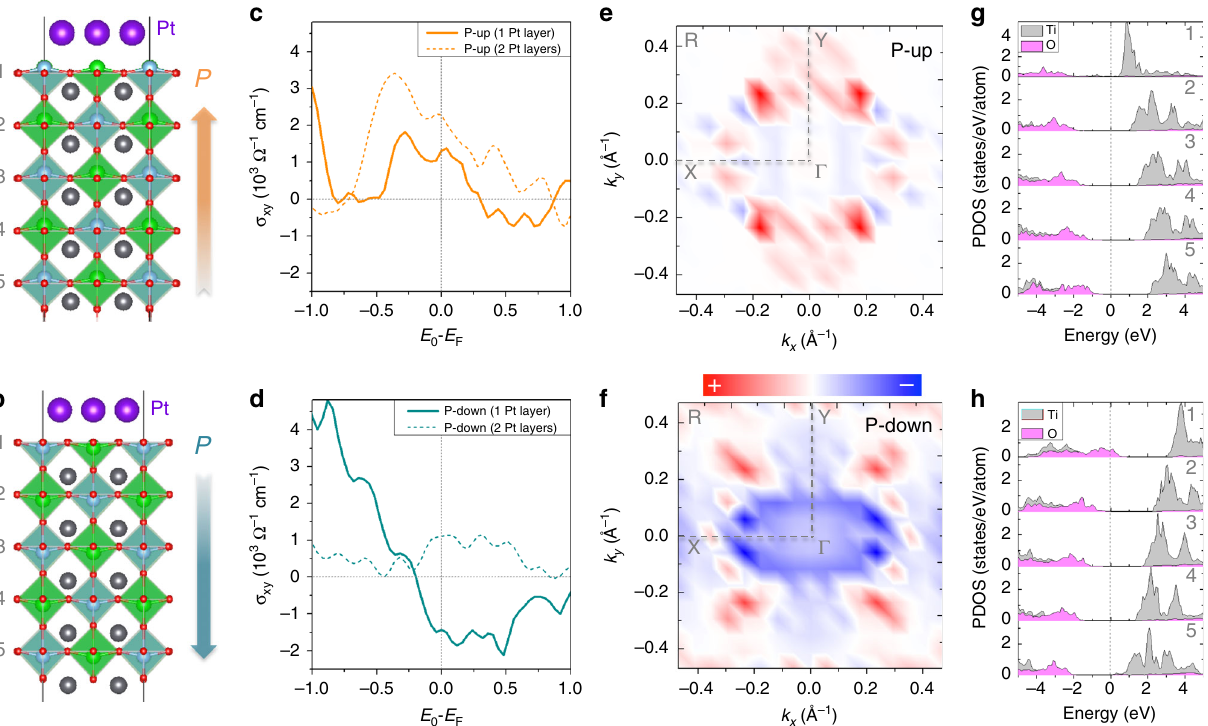
Fig. 4 DFT calculations. a , b Atomic model for a Pt adlayer on the PZT substrate with upward and downward ferroelectric polarizations out of the surface. c , d Calculated spin Hall conductivity σ xy of 1 Pt/PZT and 2 Pt/PZT. e , f Distributions of the Berry curvature in the two-dimensional Brillouin zone. Red and blue represent positive and negative contributions of Berry curvature, respectively. g , h Calculated layer projected density of states of Ti and O atoms in the PZT substrate. The vertical dashed line at E = 0 represents the position of the Fermi level. The numbers indicate the corresponding layers of Ti and O atoms counting from the interface. Pink and gray denote O-2p and Ti-3d contributions,